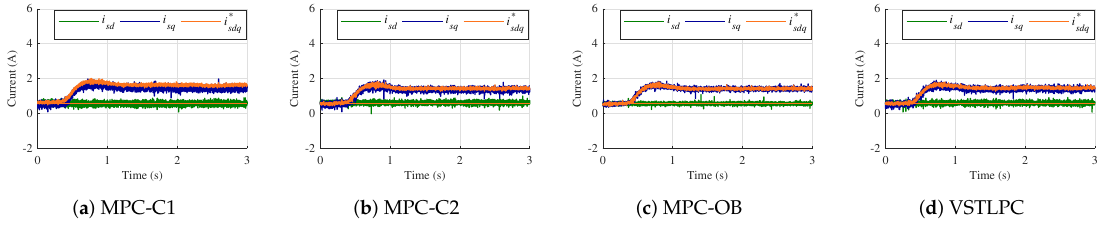
Figure 9. Evolution of d – q currents and their references for each controller in a torque step test from 0% to 60% of the nominal torque at 500